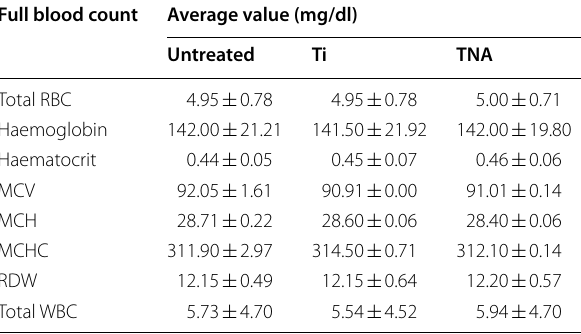
Results indicate mean values full blood count Table 3 PT and APTT profiles Coagulation assay